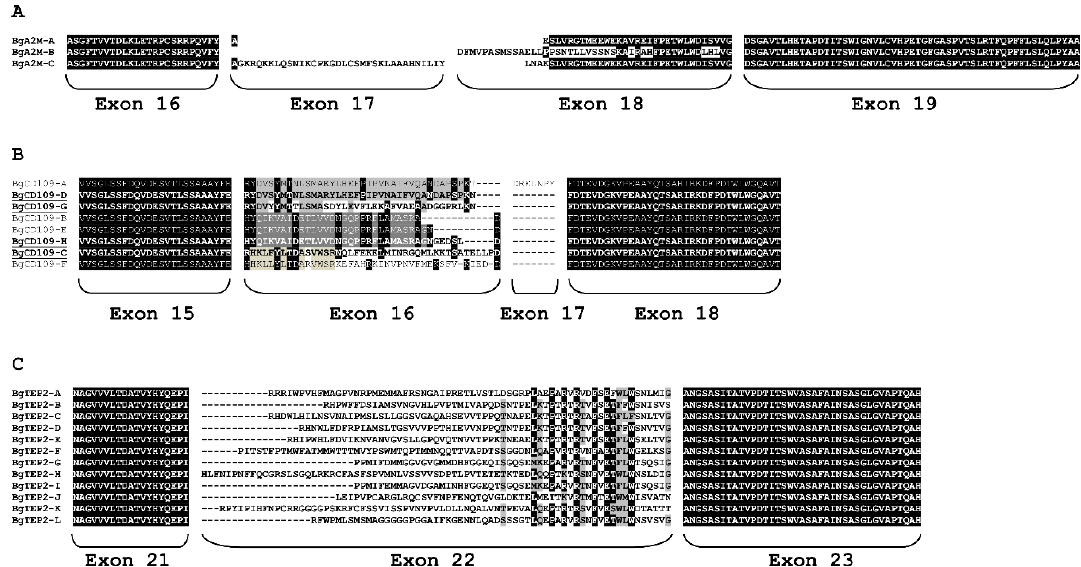
Figure 3. ClustalW alignment of alternative splice variants for three BgTEP proteins. Amino acids encoded by alternative exons corresponding to the highly variable region of some BgTEP were aligned, together with amino acids from border conserved exons, using clustalW. Identical amino acids are highlighted in black, similar ones in grey. ( A ) Alignment of BgA2M variants showing alternative splicing in exons 17 and 18. ( B ) Alignment of BgCD109 splice variants. Underlined variant names correspond to variants recovered from Biomphalaria glabrata transcriptomes. The other variants were only predicted from BglaB1 genome assembly. ( C ) Alignment of the 12 BgTEP2 splice variants.